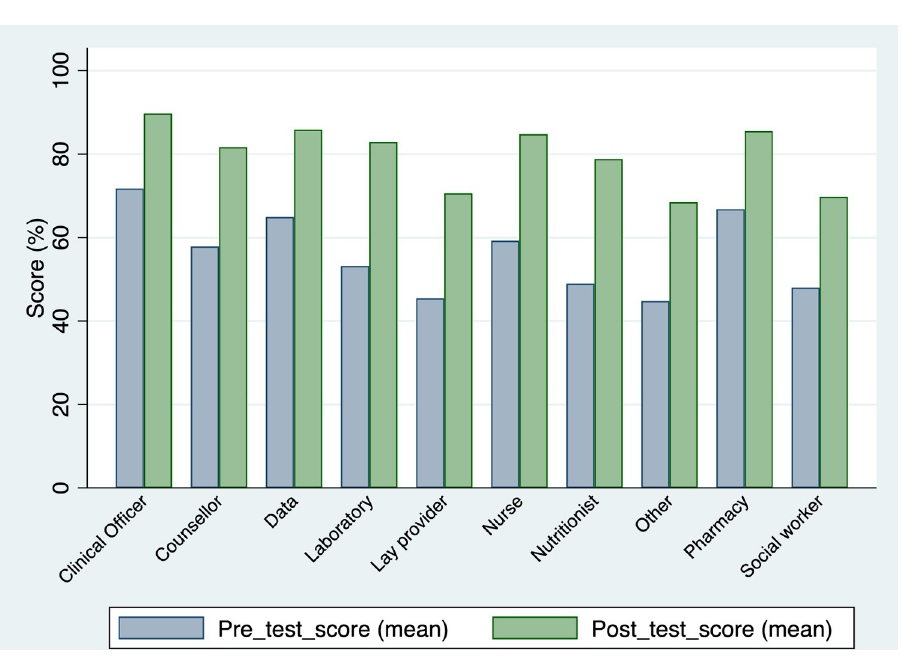
Fig 1. Pre- and post-test mean scores, by